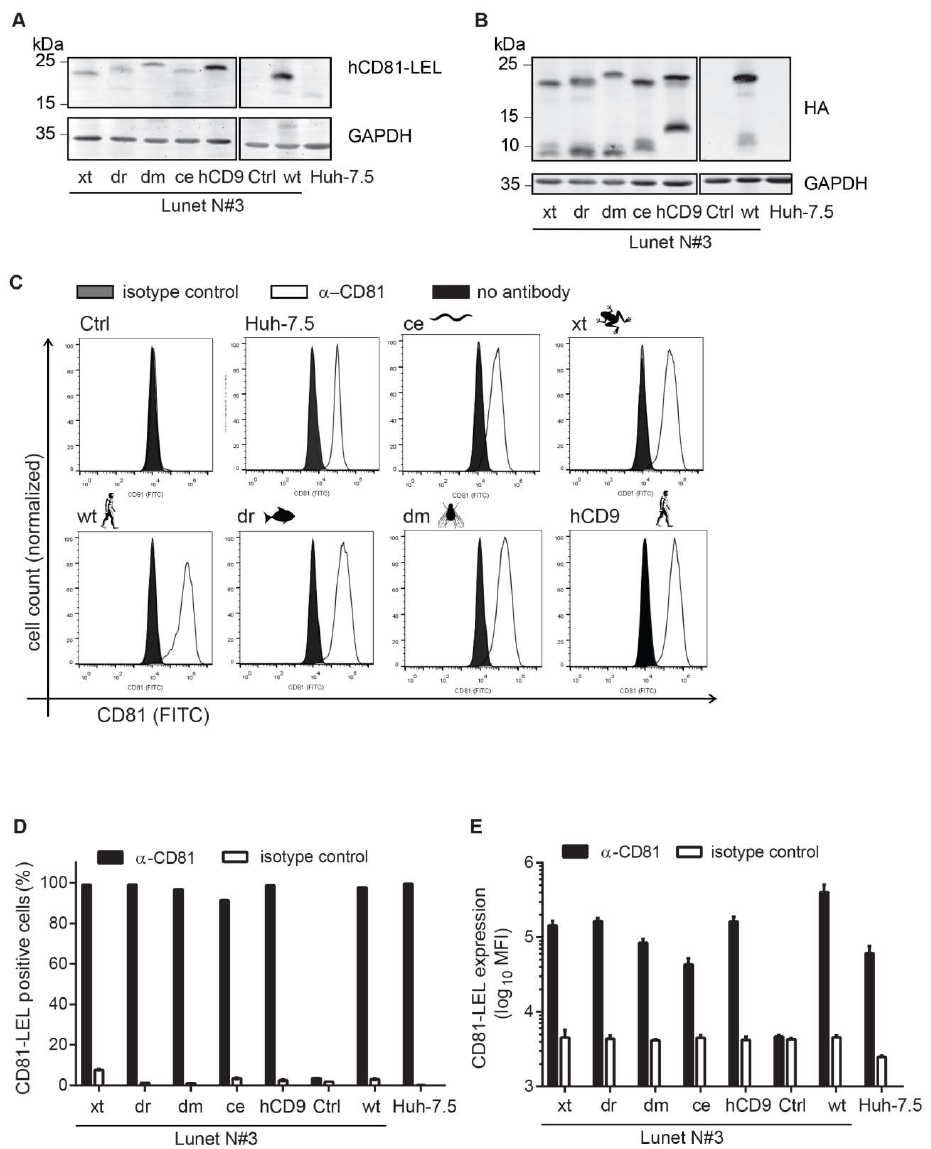
Figure 3. Generation and characterization of hCD81 chimera expressing human hepatoma cells. ( A , B ) Immunoblot for hCD81 LEL ( A ) and HA tag ( B ) in lysates from Lunet N#3 human hepatoma cells stably transduced with the indicated tetraspanin construct. GAPDH served as loading control and lysates from Huh-7.5 cells with endogenous hCD81 as positive control; ( C – E ) Cell surface staining of hCD81 on transduced Lunet N#3 cells as described in Figure 1C–E. Immunoblots and histograms are representative of at least three independent experiments and histograms show 30,000 cells per measurement. Mean + SD of three independent experiments shown.